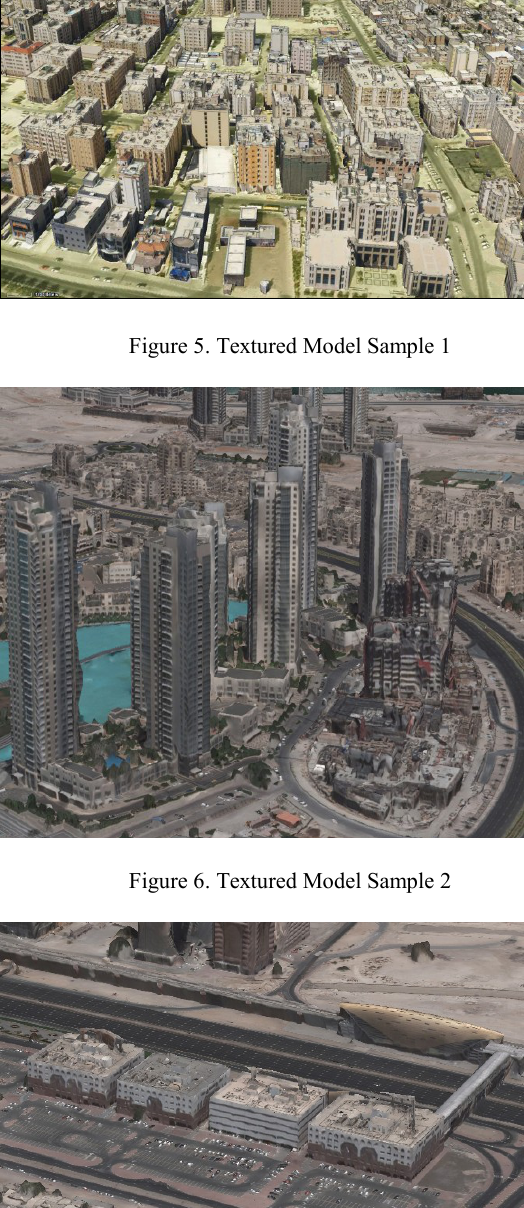
Figure 7. Textured Model Sample